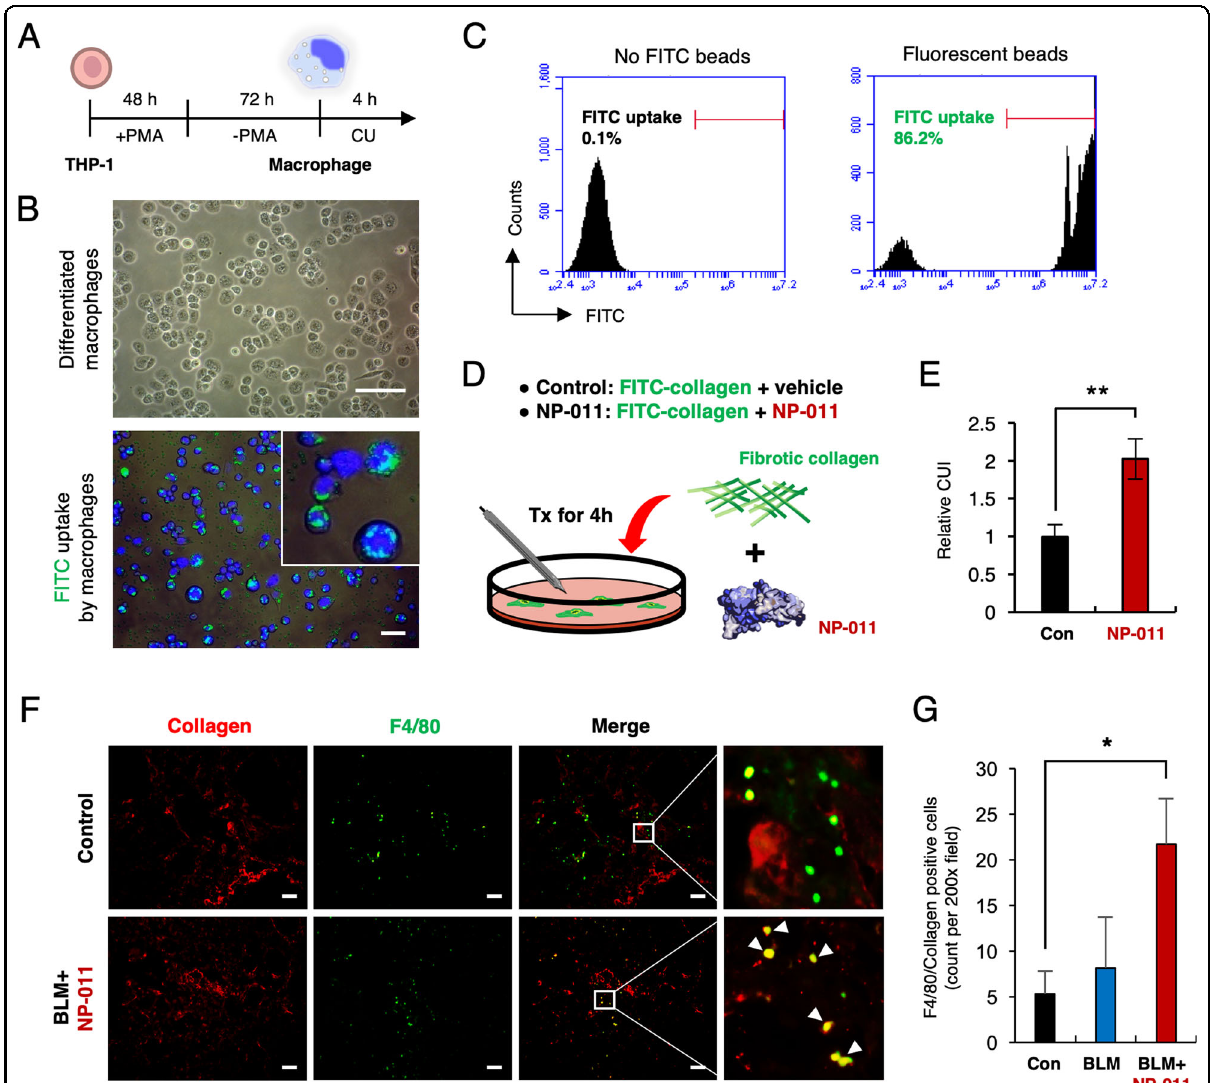
Fig. 4 NP-011 facilitates macrophage-mediated collagen uptake in lung tissues. A Overall schematic schedule for macrophage differentiation from monocyte by treatment of PMA. B Representative images for differentiated macrophages (upper panel) and FITC-labeled beads uptake by differentiated macrophages (lower panel). Scale bar, 10 μ m. C Flow cytometry results showed that the FITC beads were uptaken by